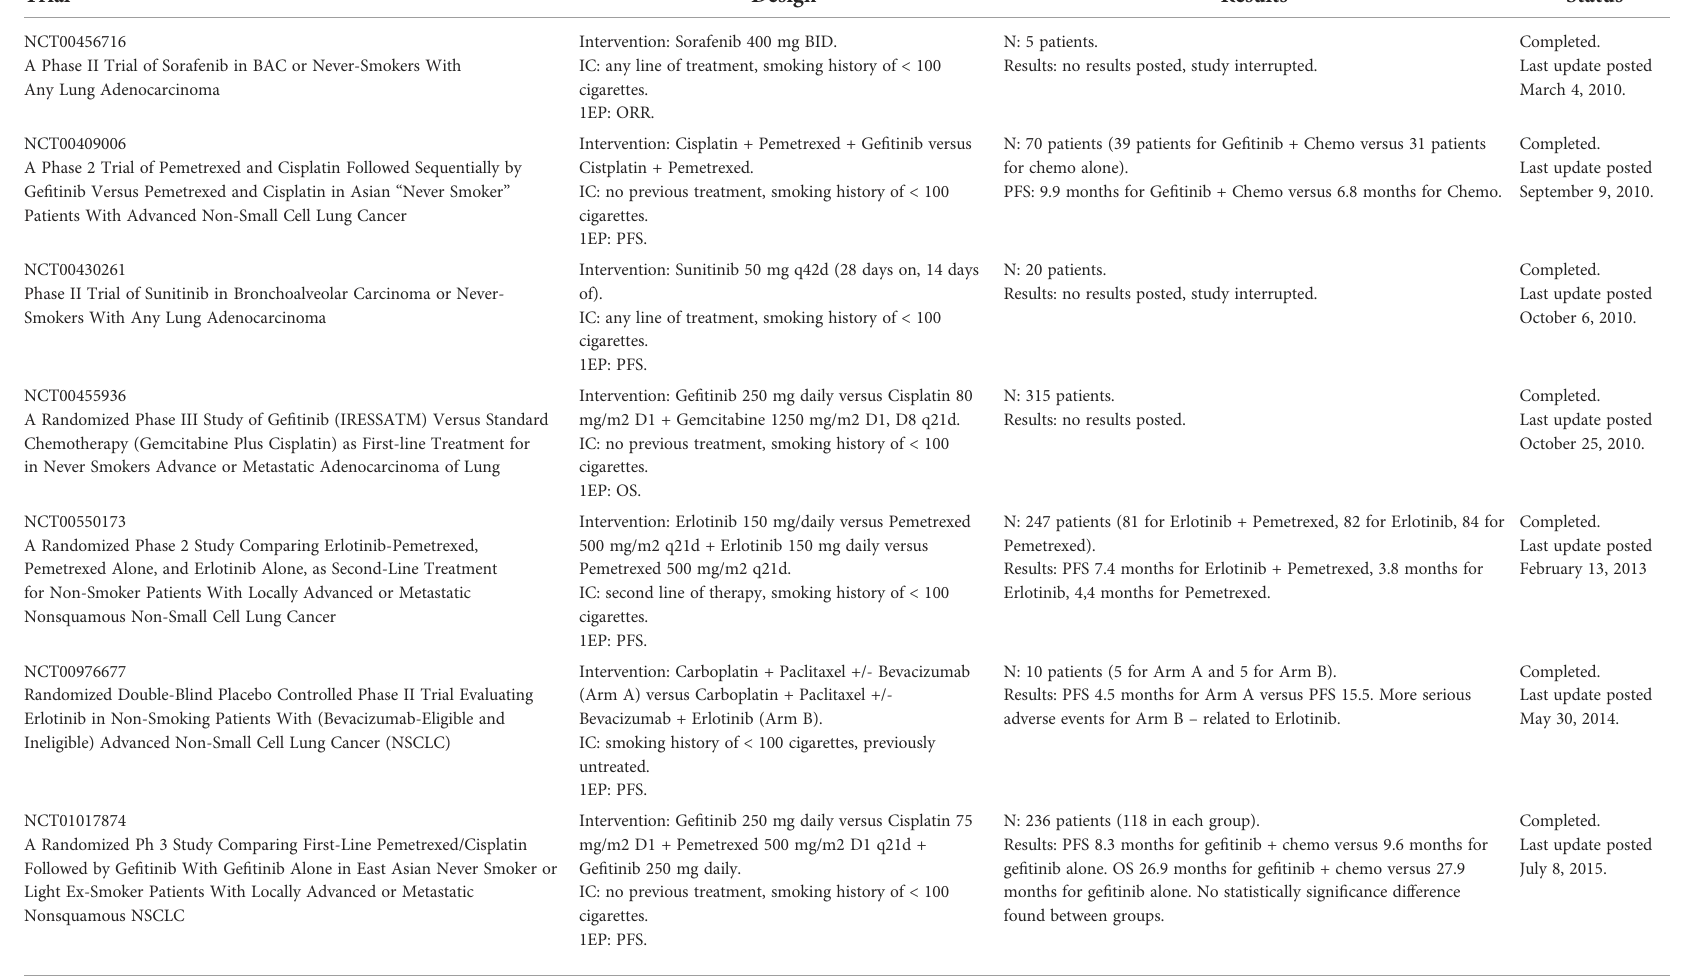
TABLE 1 List of clinical trials in non-small cell lung cancer that focused on non-smokers. Trial Design Results